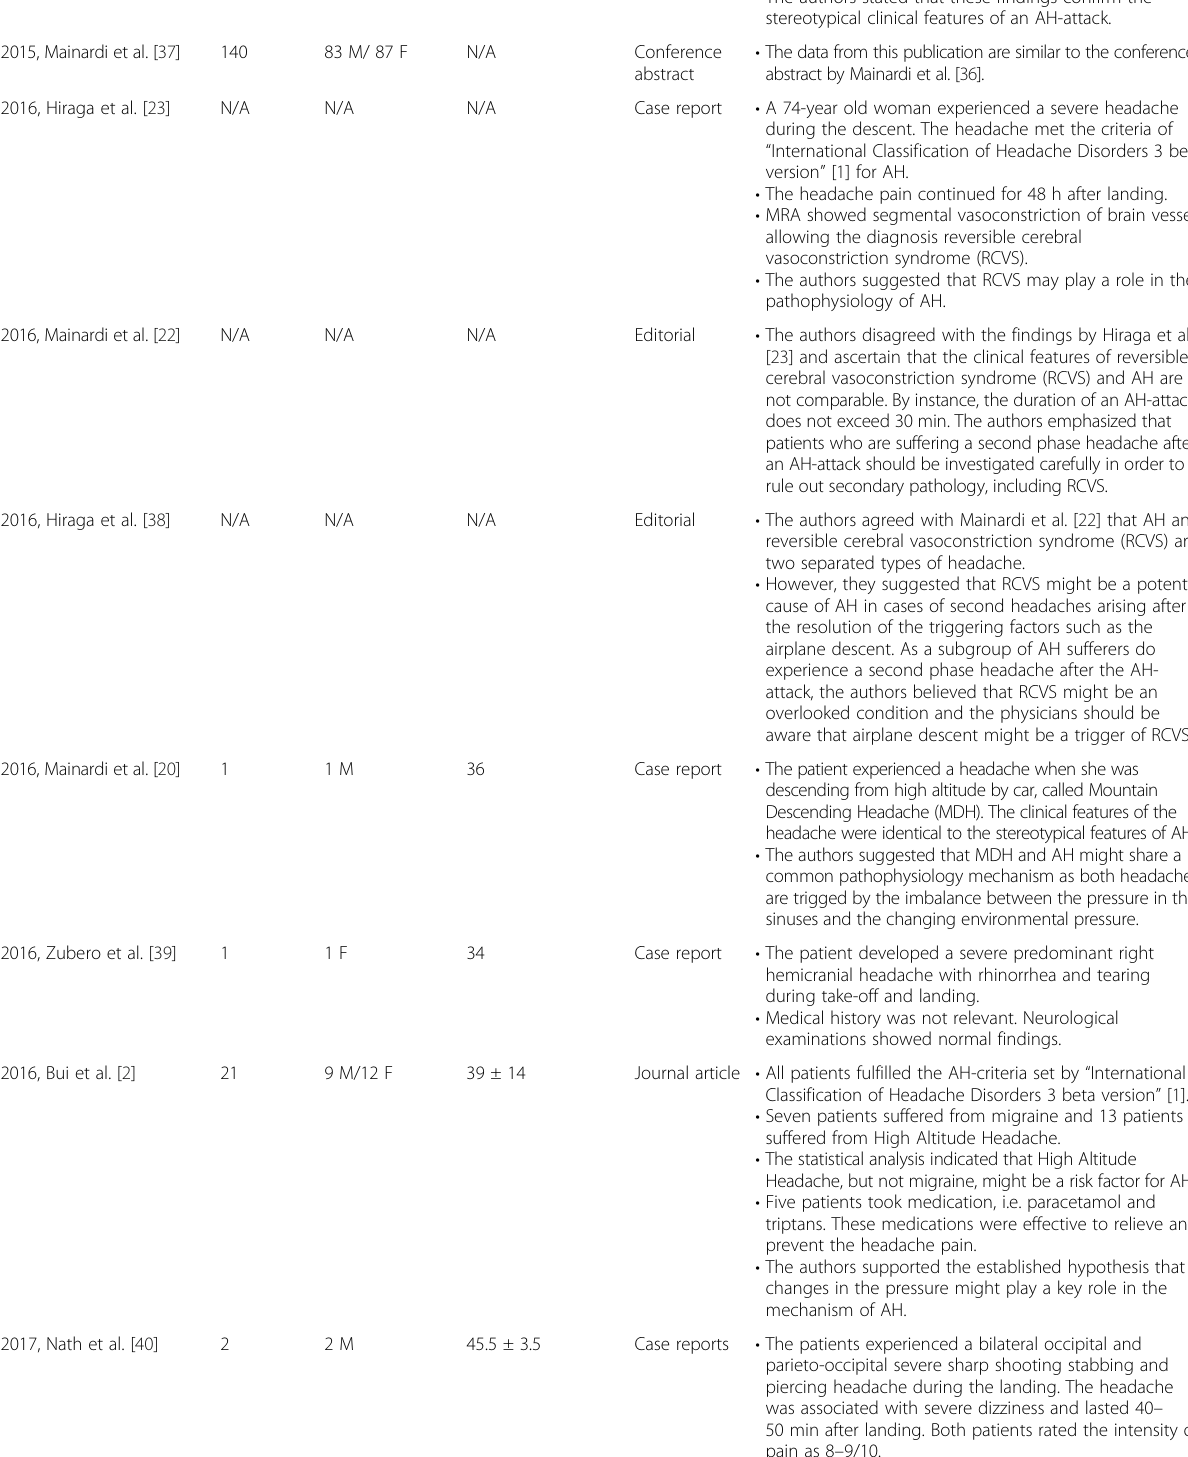
(cid:129) The authors stated that these findings confirm the stereotypical clinical features of an